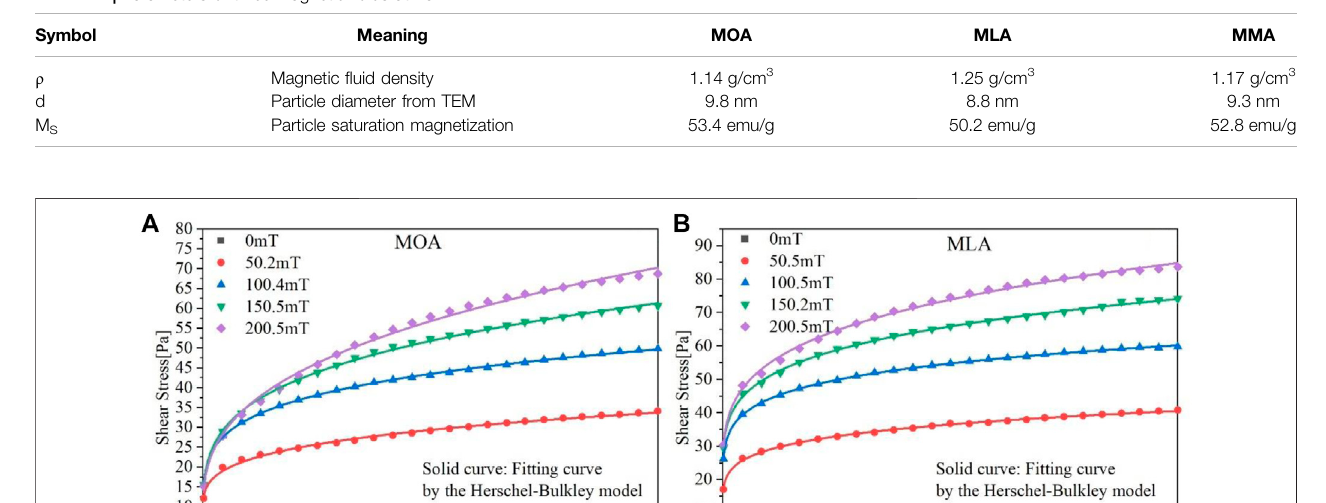
TABLE 2 | Parameters of three magnetic fl uids at 20 ° .